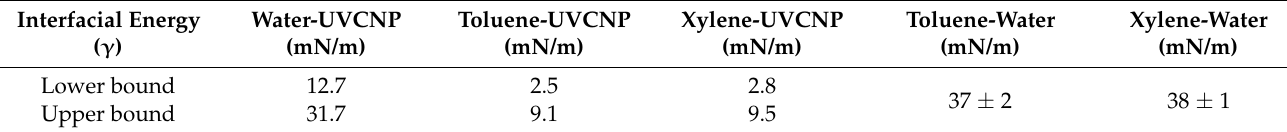
Table 1. Energy values of the liquid-solid and liquid-liquid interfaces.